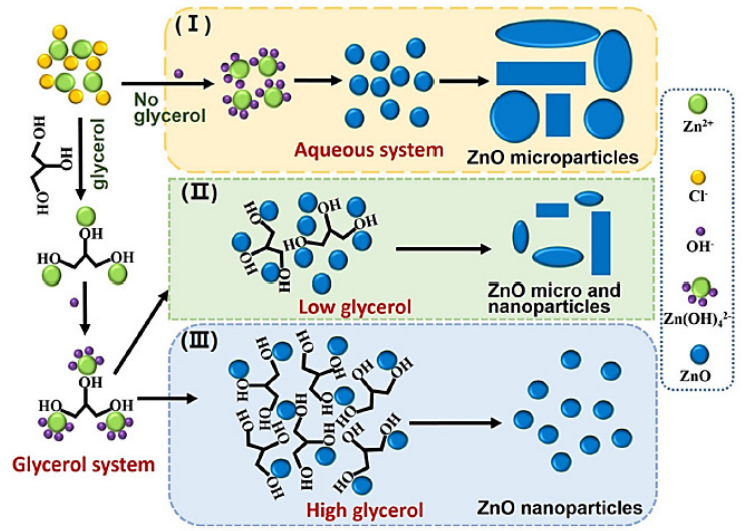
Figure 8. Schematic presentation of glycerol role in the synthesis process of ZnO nanoparticles. Reproduced with permission from [40], published by Springer Nature, 2018.